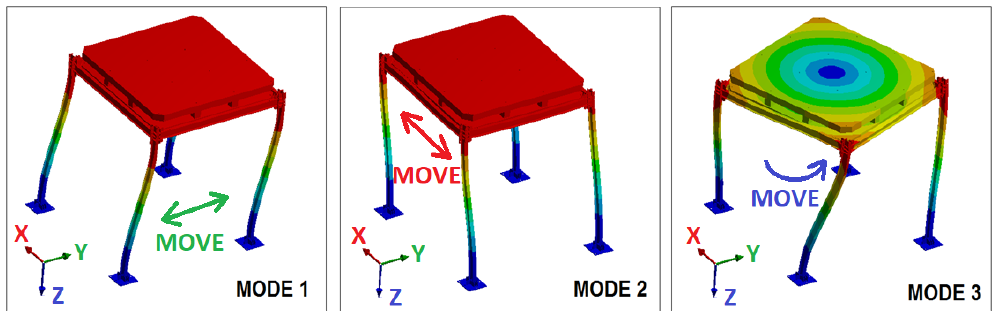
Figure 7. Frame ’ s vibration modes to be tested. Figure 7. Frame’s vibration modes to be tested.